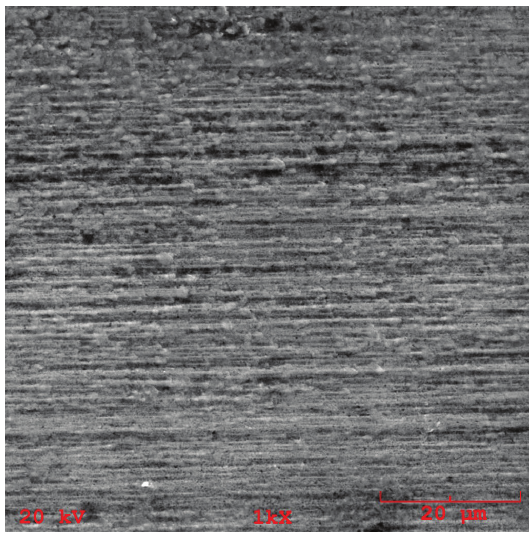
Figure 13. SEM micrograph referring to the wear track of AISI H13 sample solid nitrided 10h.